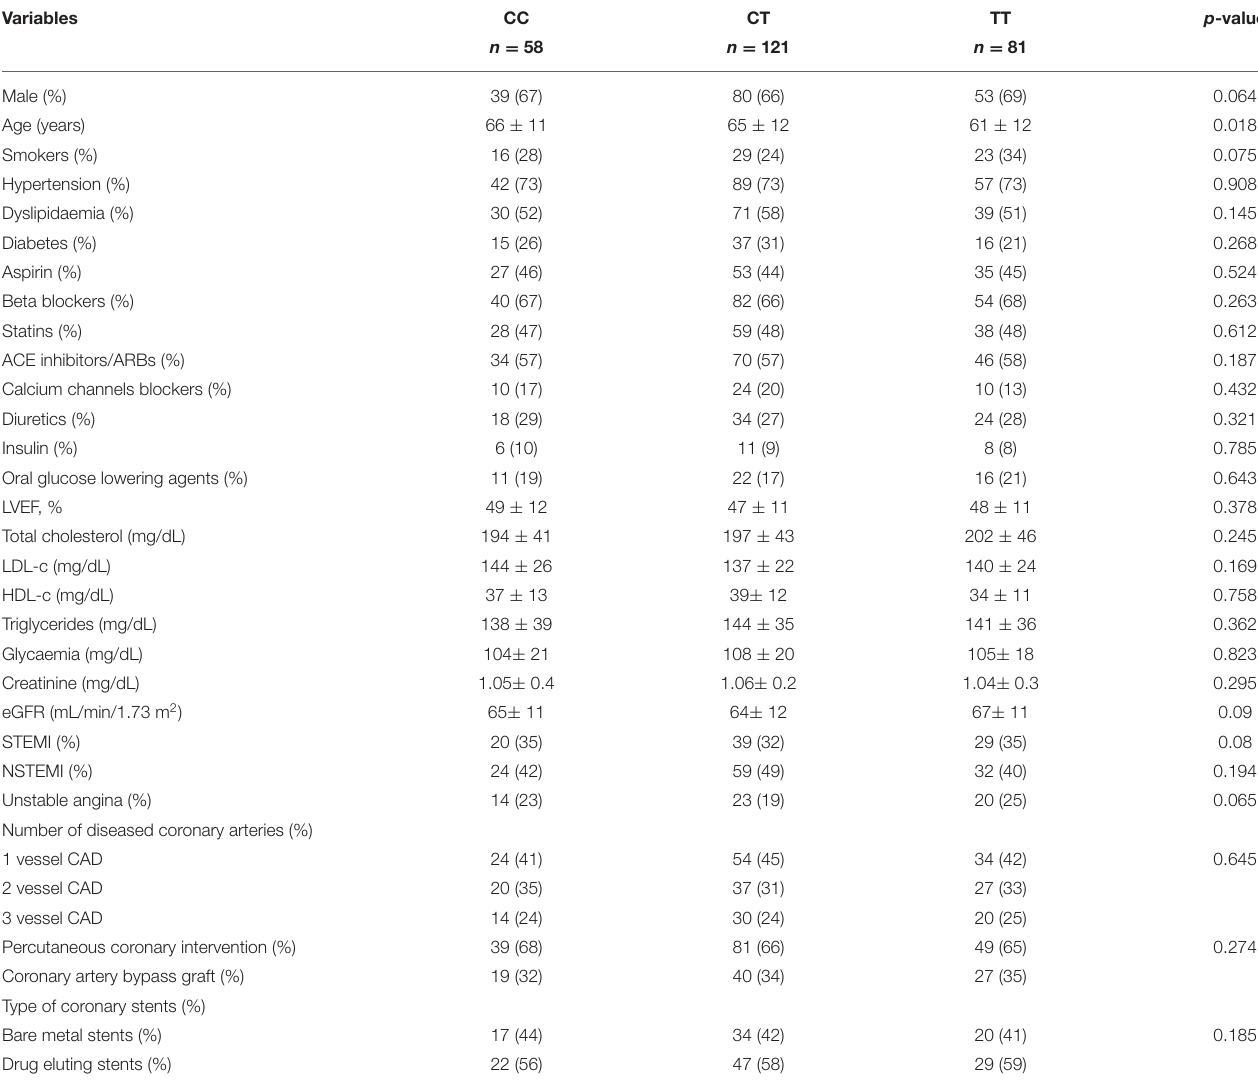
TABLE 2 | Main clinical variables of the study sample according to NDUFC2/ rs11237379 genotype at the time of a first ACS